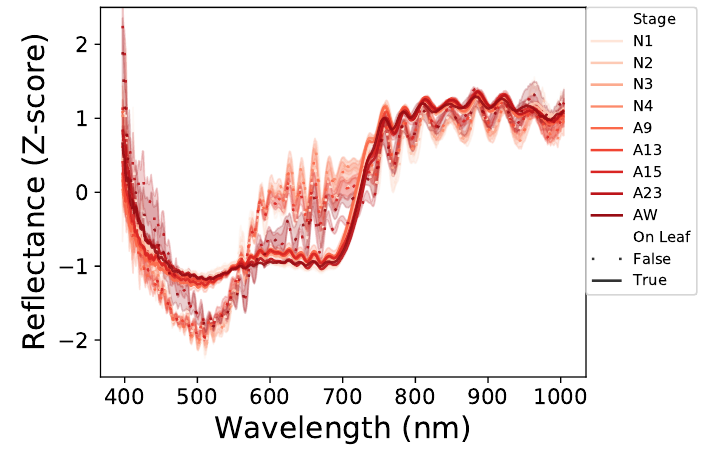
( e ) Z-score and white–dark normalized spectra of A. pisum YR2 (pink aphids).